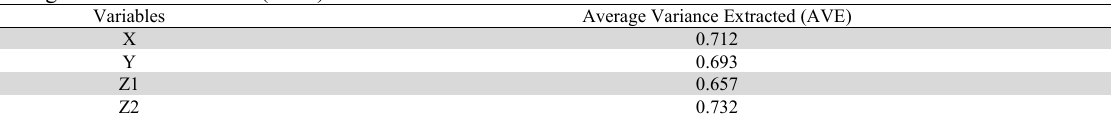
Average Variance Extracted (AVE)